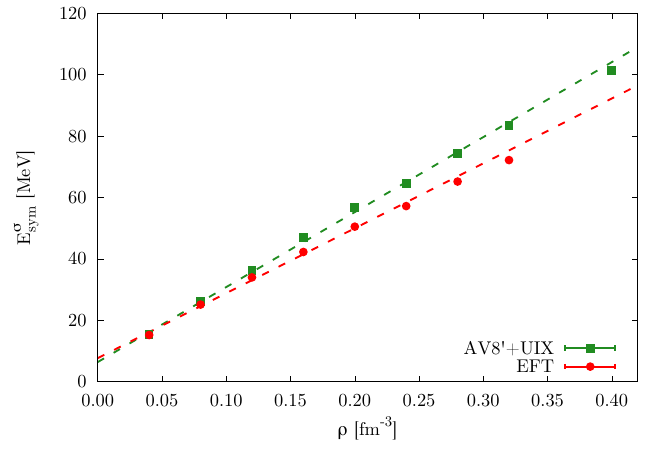
Figure 9. AFDMC results for the spin symmetry energies. Statistical Monte Carlo uncertainties are smaller than the symbols. The dashed lines are linear fit to to the AFDMC results.